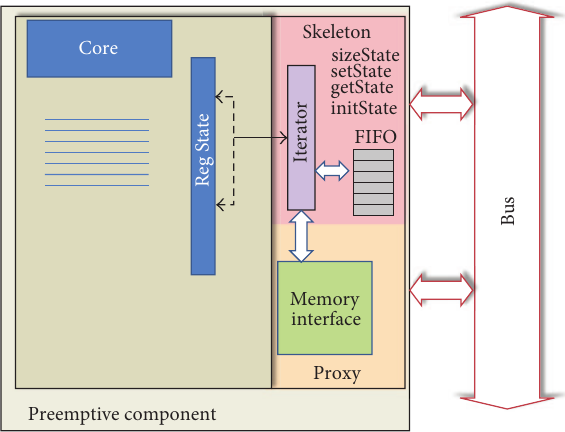
Figure 3: State management of preemptive components.